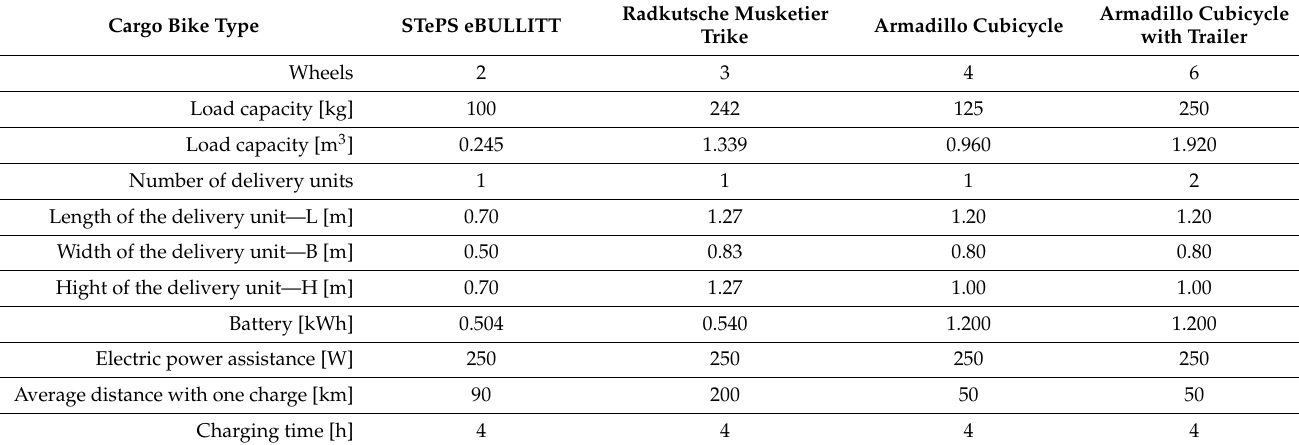
Table 1. The parameters of the examined cargo bike